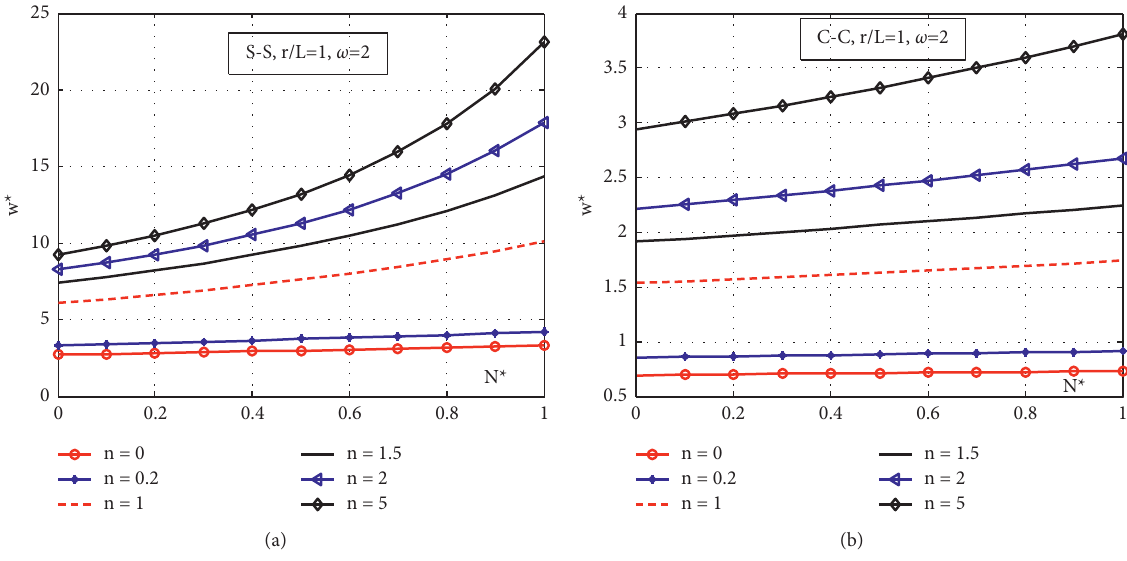
Figure 7: The relationship between the axial compressive stress and the volume fraction exponent ( n ) and the nondimensional maximum deflection of the FG beam, K ∗ w � 20, K ∗ s � 5, and α � 0.2. (a) S-S. (b) C-C.